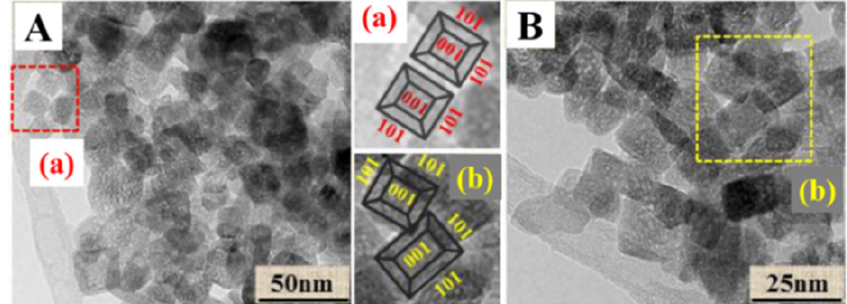
Figure 6. ( A , B ) HRTEM images of s-TiO 2 (a,b) partial enlarged drawing [41].